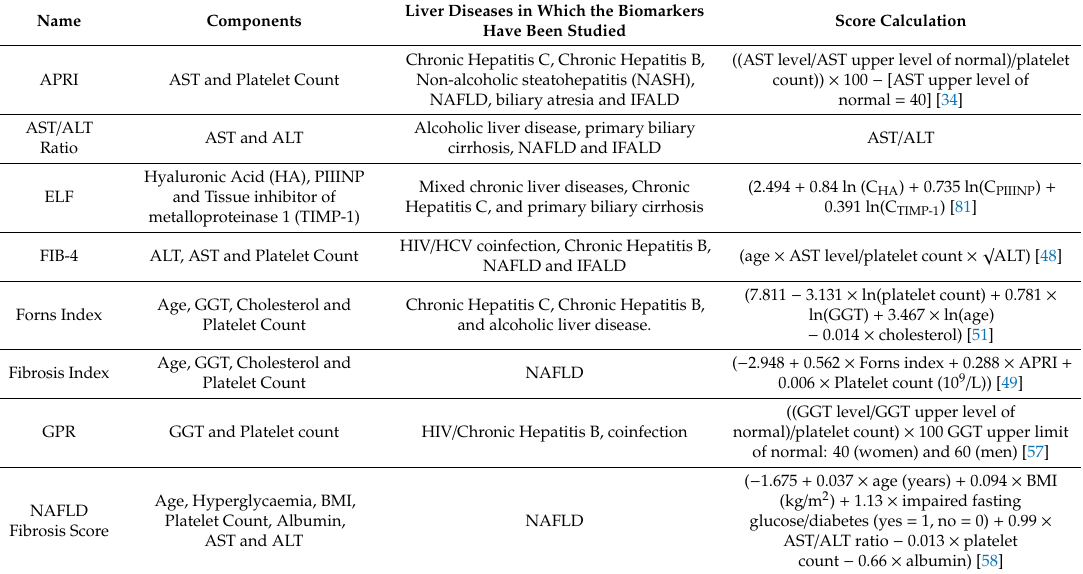
Table 1. Selected combinations of biomarkers for the assessment of liver